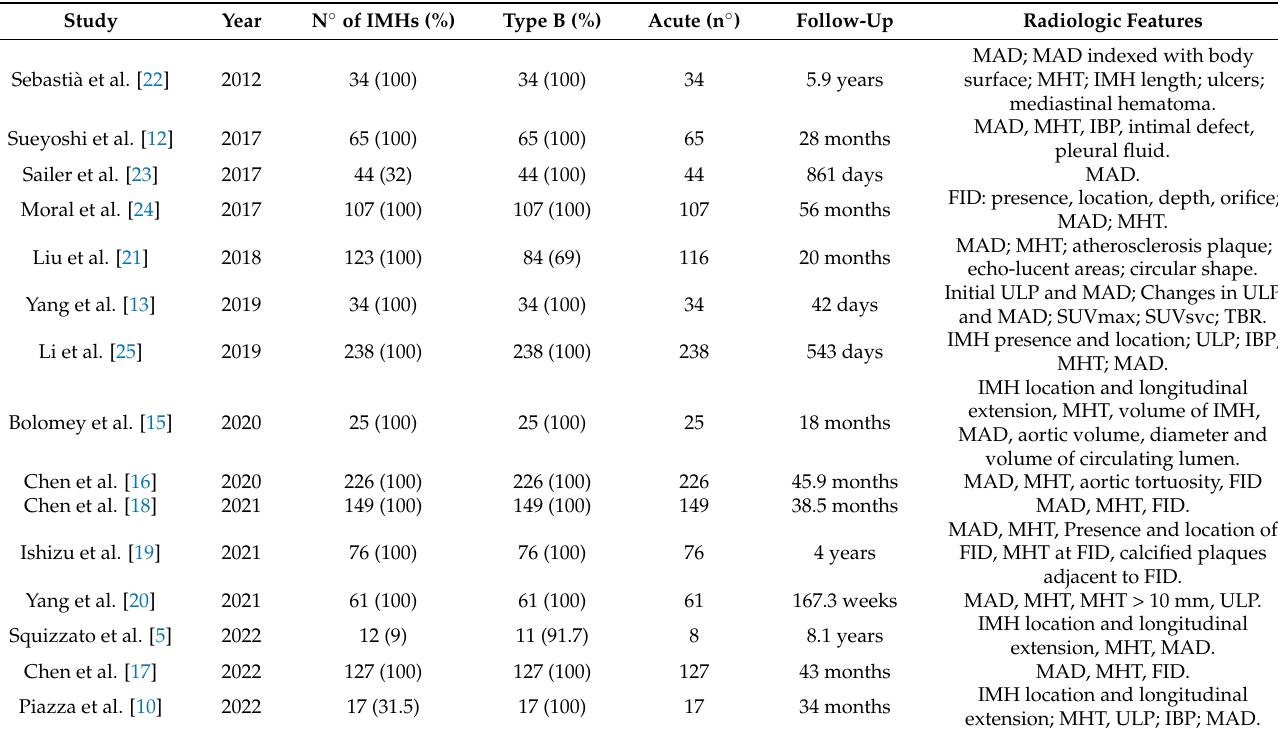
Table 2. Baseline characteristics of studies on intramural hematomas (IMHs). Type B includes locations in the descending and abdominal aorta. All imaging markers that have been tested in order to identify an association with aortic-related adverse events are listed in the “radiologic features” column. MAD: maximum aortic diameter; MHT: maximum hematoma thickness; ULP: ulcer-like projections; FID: focal intimal disruptions; IBP: intramural blood pools; SUV max : maximum standardized uptake of the aortic wall; SUV svc : maximum standardized uptake of the superior